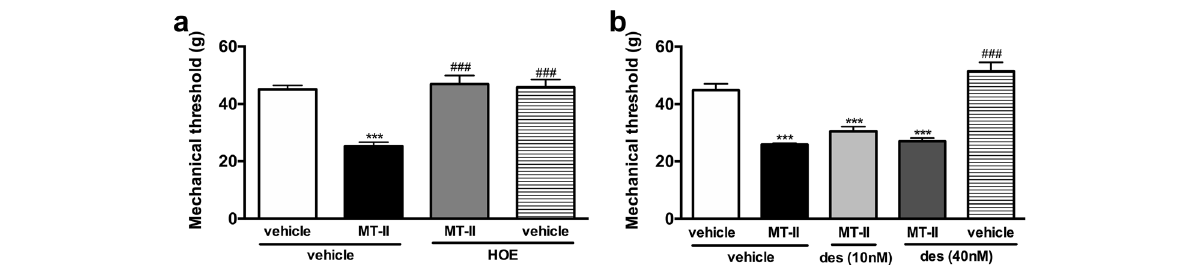
Fig. 5 Involvement of bradykinin on MT-II-induced articular hyperalgesia. MT-II (10 μ g/joint) or PBS (vehicle) was injected in tibio-tarsal articulation (25 μ L). Pain threshold was determined using a modified electronic pressure-meter test 8 h after MT-II injection, and represented as force (in g ). ( a ) A bradykinin B 2 receptor antagonist icatibant (HOE 140, 0.75 μ mol) or ( b ) a bradykinin B 1 receptor antagonist Lys-(Des-Arg 9 ,Leu 8 )-bradykinin (des,